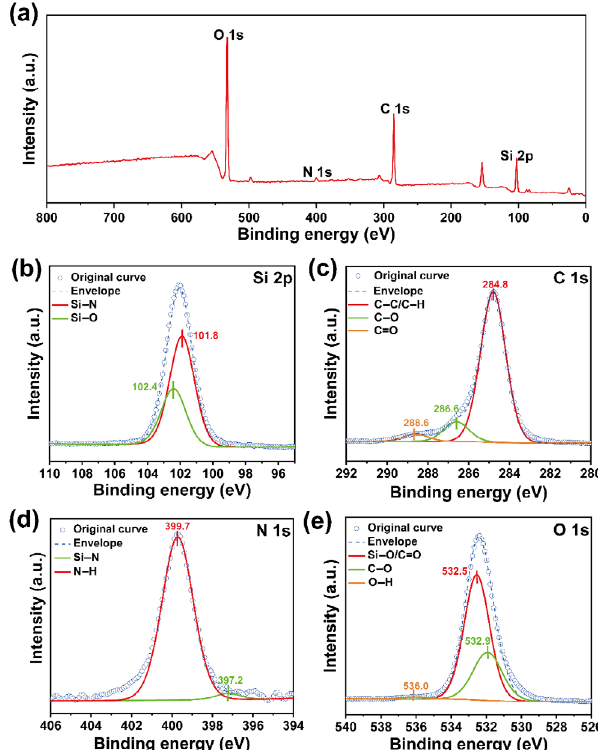
Fig. 8 XPS spectra of the wear area on the glass surface after PEG10000-TA lubrication. (a) Full pattern, (b) Si 2p, (c) C 1s, (d) N 1s, and (e) O 1s. The load applied was 4 N, and the maximum linear velocity was 0.025 m/s. The mass fractions of PEG10000 and TA in the lubricant used were 45 wt% and 2 wt%,